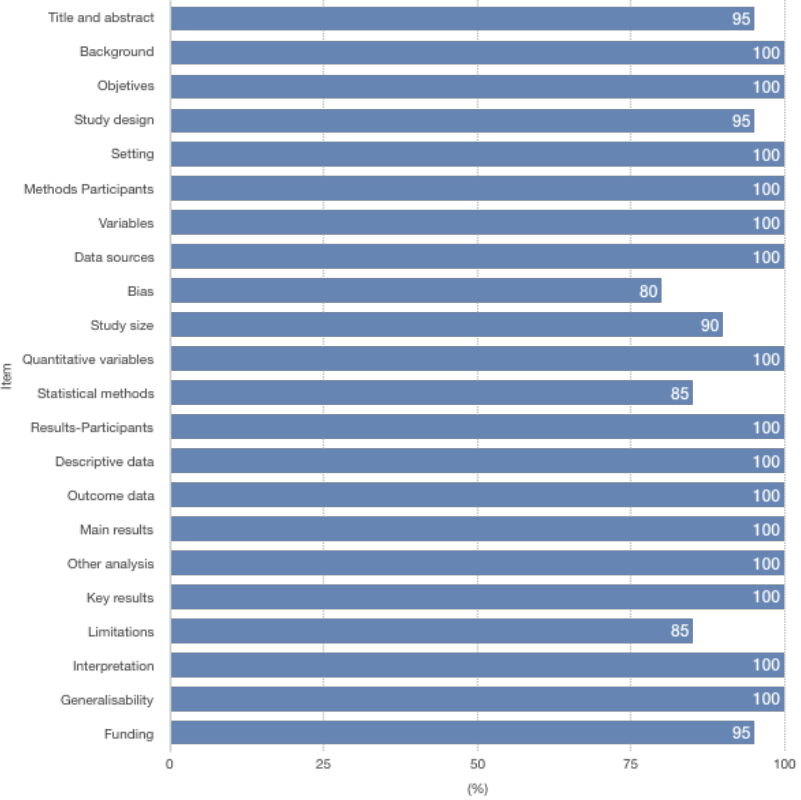
Figure 2. Methodological quality evaluation of articles included.